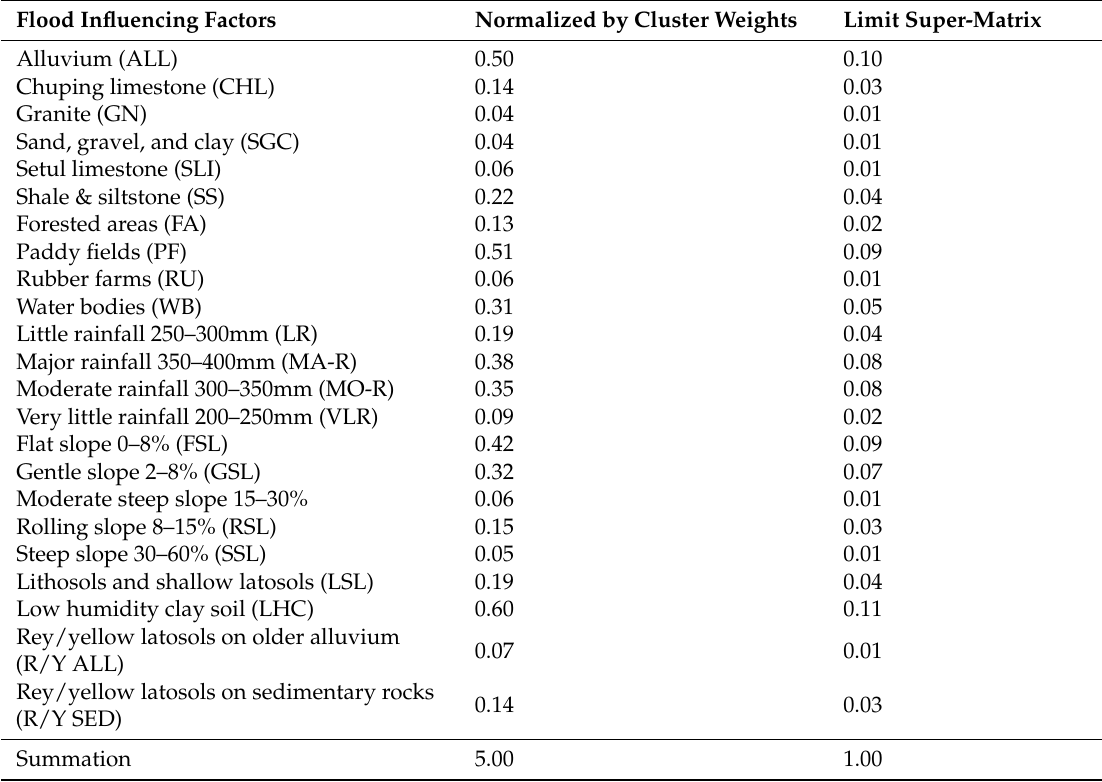
Table 5. Priority vectors of the nodes.